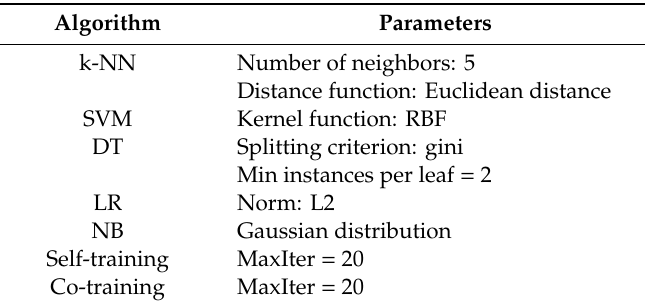
Table 2. Configuration of exploited algorithms’